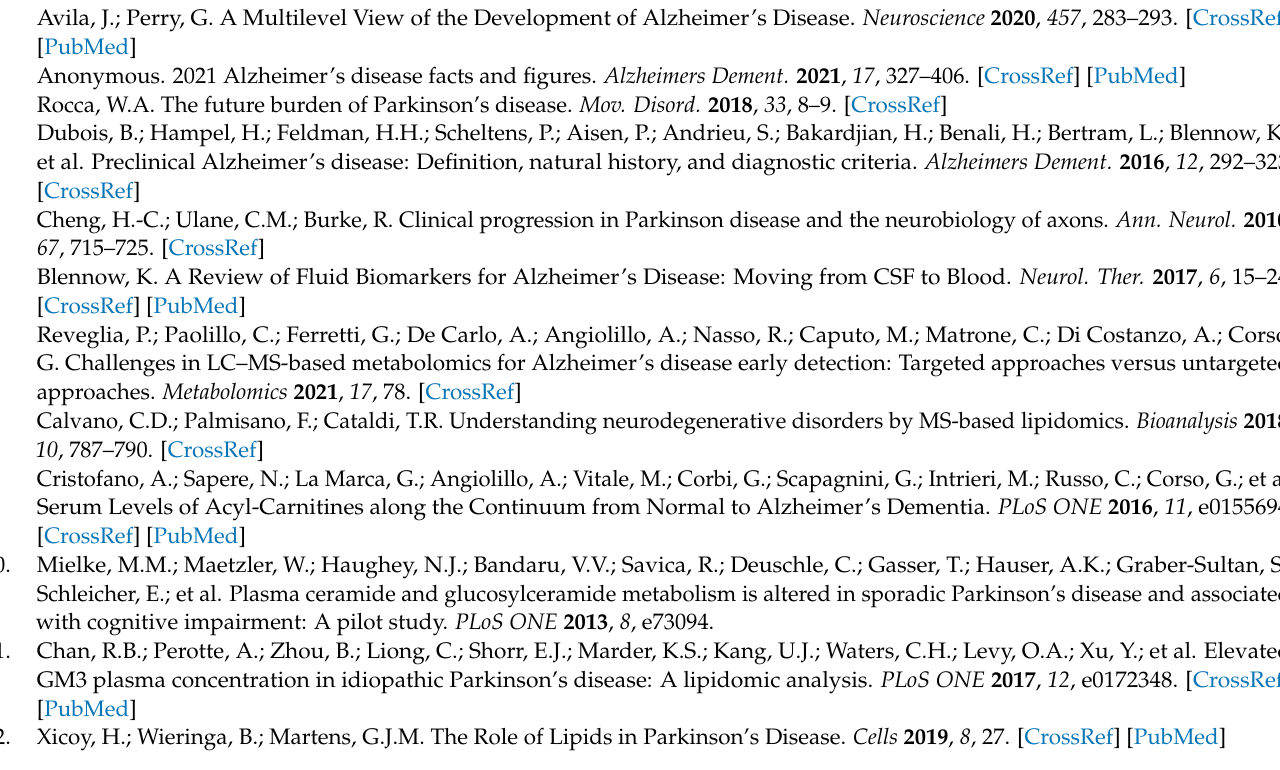
individual lipid component can be visualized by hovering over the corresponding dot. Left panel: Scores plot after projection of the residuals onto the space spanned by the only significant PCs SCA1 and SCA2. Right panel: Variable loadings on SC1 (full lines), and variable loading on SC2 (dotted lines); only the significant loadings are displayed and the variables are colored according to the lipid species described in the legend, Table S1: Correlation and p -values of the Spearman’s correlation matrices in Figure 1, Table S2: List of analyzed sebum lipids, their classification and